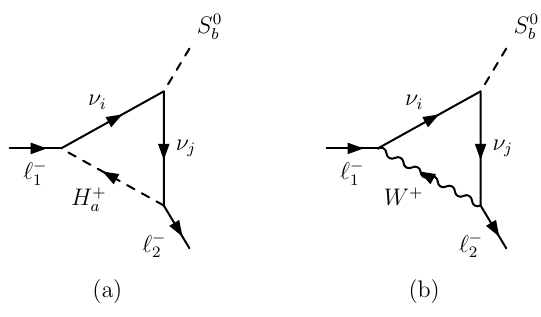
Figure 19 . Two diagrams for S 0